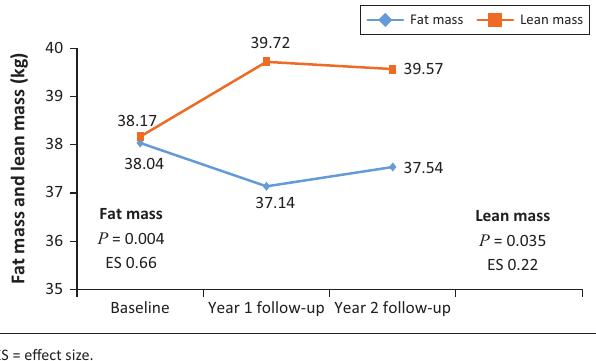
FIGURE 4: Lean and fat mass changes over 2 years from baseline. TABLE 3: Correlation between serum vitamin D, lifestyle, health and body composition variables: Spearman’s correlations between lifestyle, demographic variables and body composition. Variable